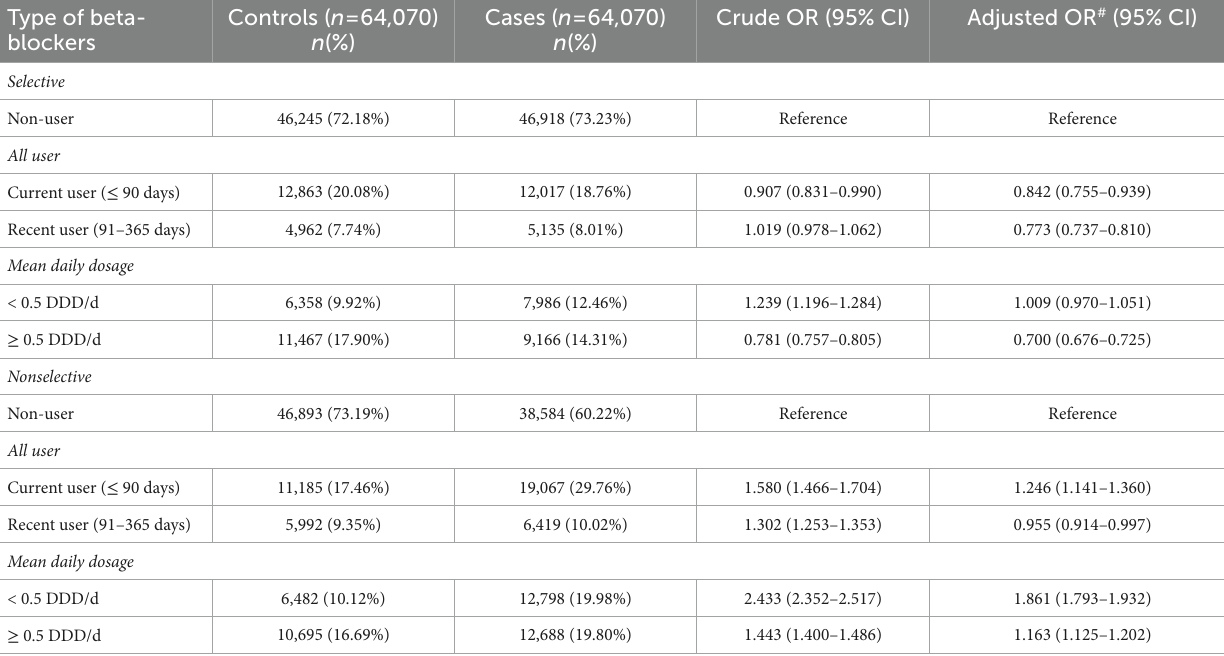
TABLE 2 The association between the use of beta-blockers and the risk of sepsis.